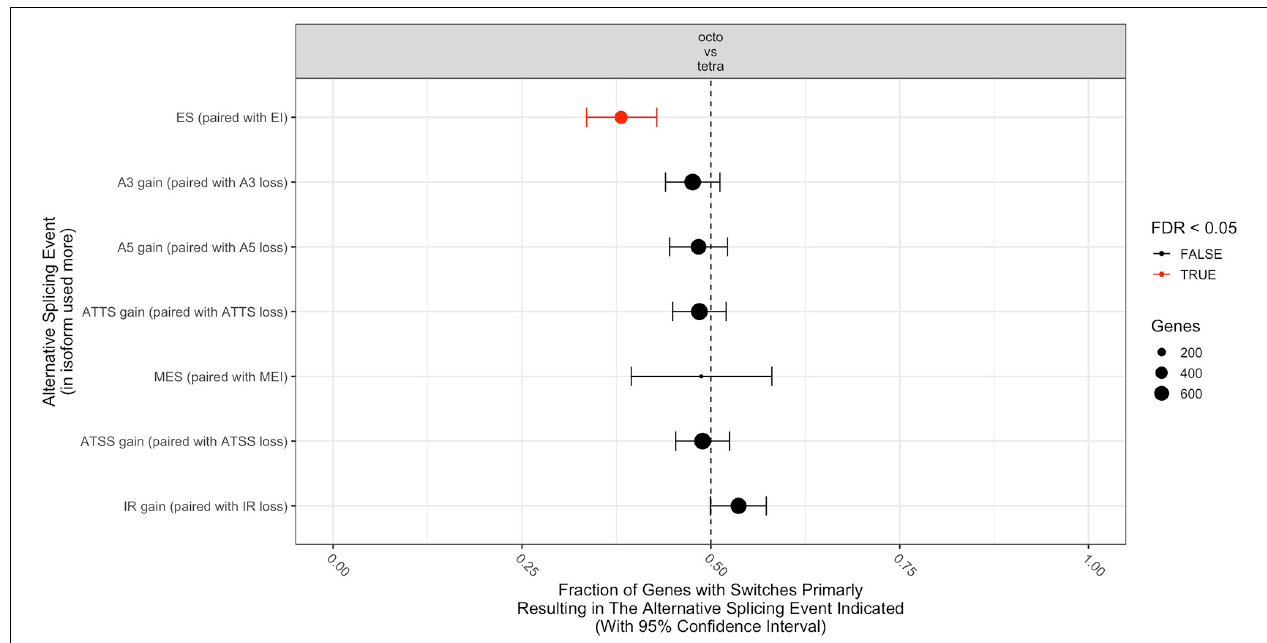
FIGURE 3 | Compared consequences of alternative splicing event between ploidy levels (octo- and tetraploid) in Phragmites australis , inferred from biased isoforms in each group. Fraction of genes with switches primarily resulting in the alternative splicing event were indicated with 95% Confidence Interval. Data labeled with red indicated the significant trend, with False Discovery Rate < 0.05. Significant isoform usage was indicated with an asterisk. * p -value < 0.05, *** p -value < 0.001, ns, no significant difference. Compare to octoploids, tetraploids showed higher percentage of genes (about 72%) with consequences of Exon Inclusion (EI), and only around 38% of the genes showed consequences of Exon Skipping